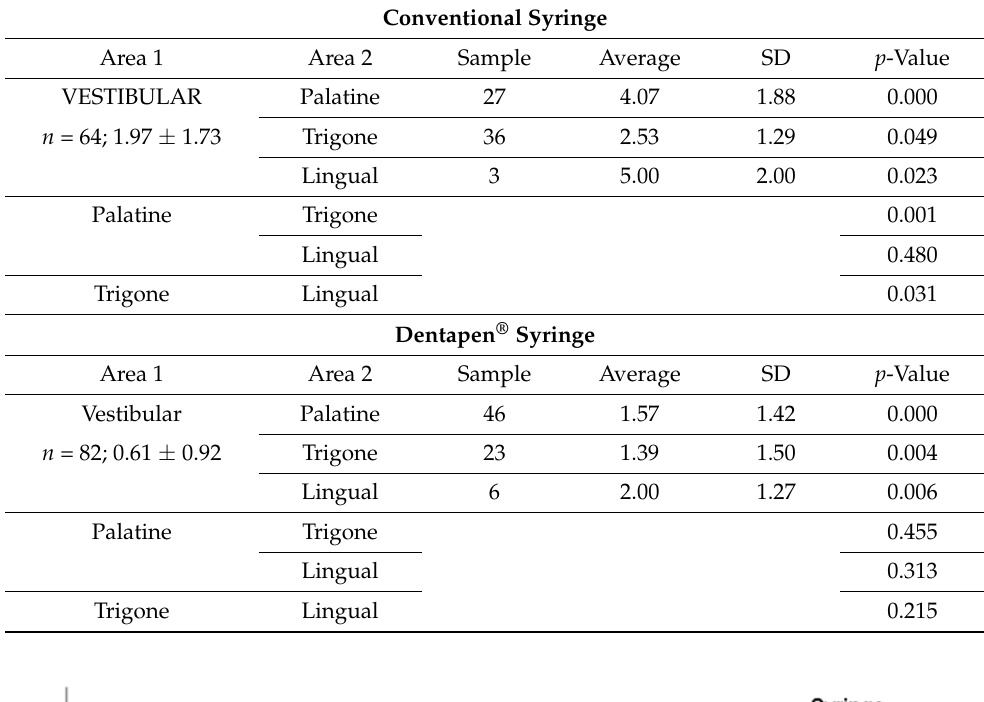
Table 4. VAS comparison and statistical significance based on the area of injection and the type of syringe used.